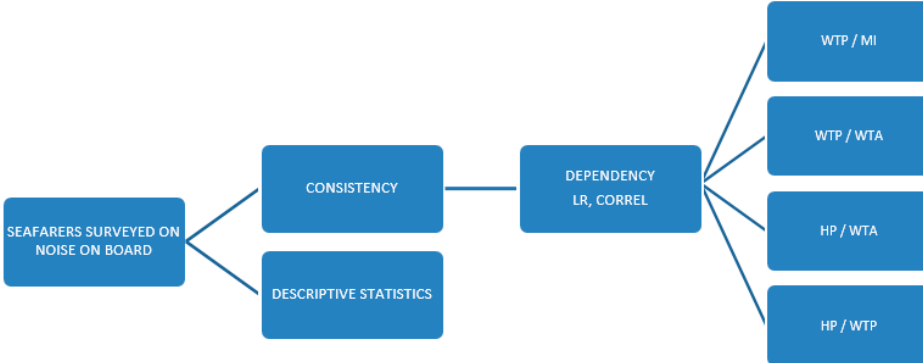
Figure 1. Flow chart of the research.